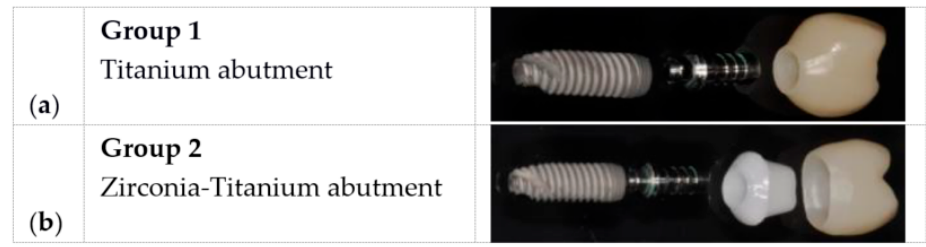
Figure 4. View of the constructive sample of the two groups: ( a ) group 1 and ( b ) group 2.